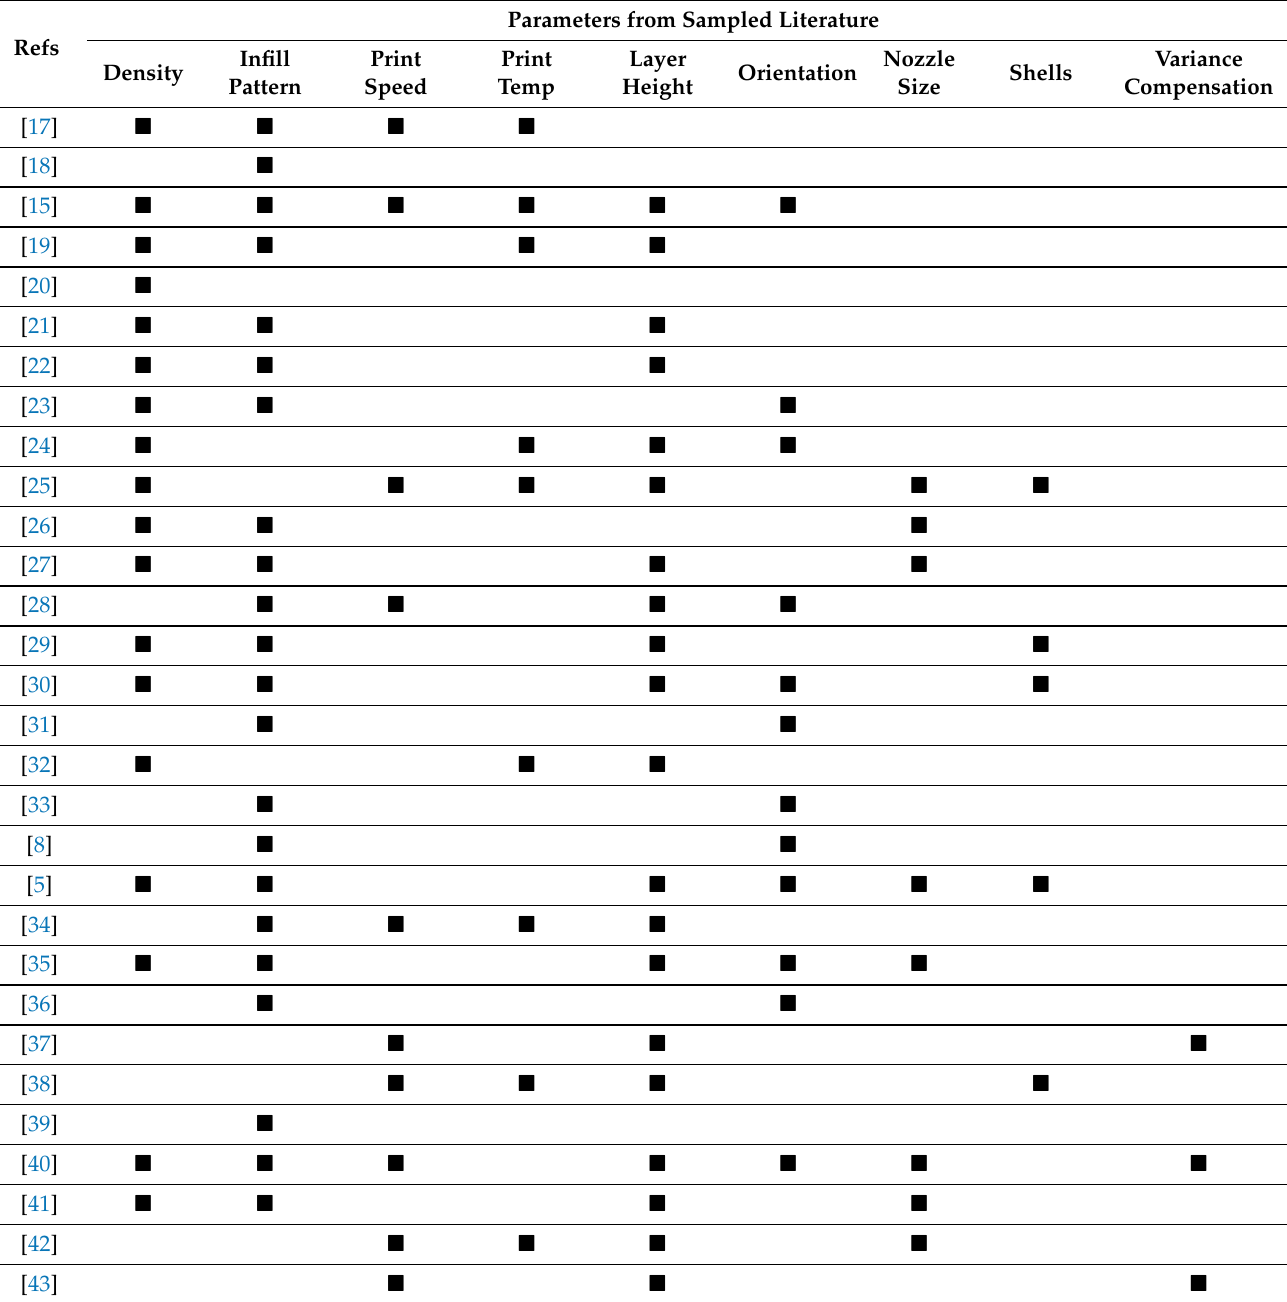
Table 1. Example parameter control/optimization studies from a review of 30 recent papers on FDM.